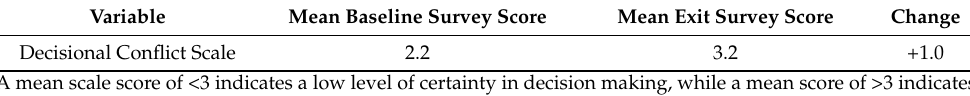
Table 4. Participant certainty in treatment decision making ( N = 5).